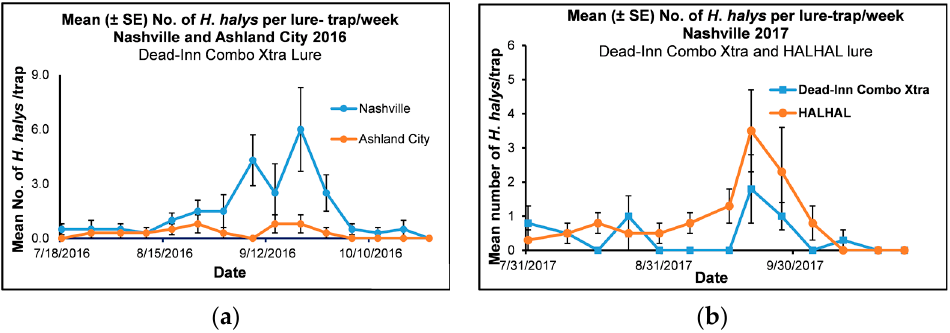
Figure 2. Mean (± SE) number of adult and immature Halyomorpha halys collected per trap/week in soybeans from ( a ) July to October 2016 in Nashville (Davidson County) and Ashland City (Cheatham County), Tennessee using a Dead-Inn Combo Xtra lure (combined Dead-Inn H . halys and Harlequin bug lures) with H . halys pyramid traps ( b ) July to October 2017 conducted in Nashville (Davidson County), Tennessee using two H . halys lures (Dead-Inn Combo Xtra [combined Dead-Inn H . halys and Harlequin bug lures] and HALHAL 25) with H . halys pyramid traps.